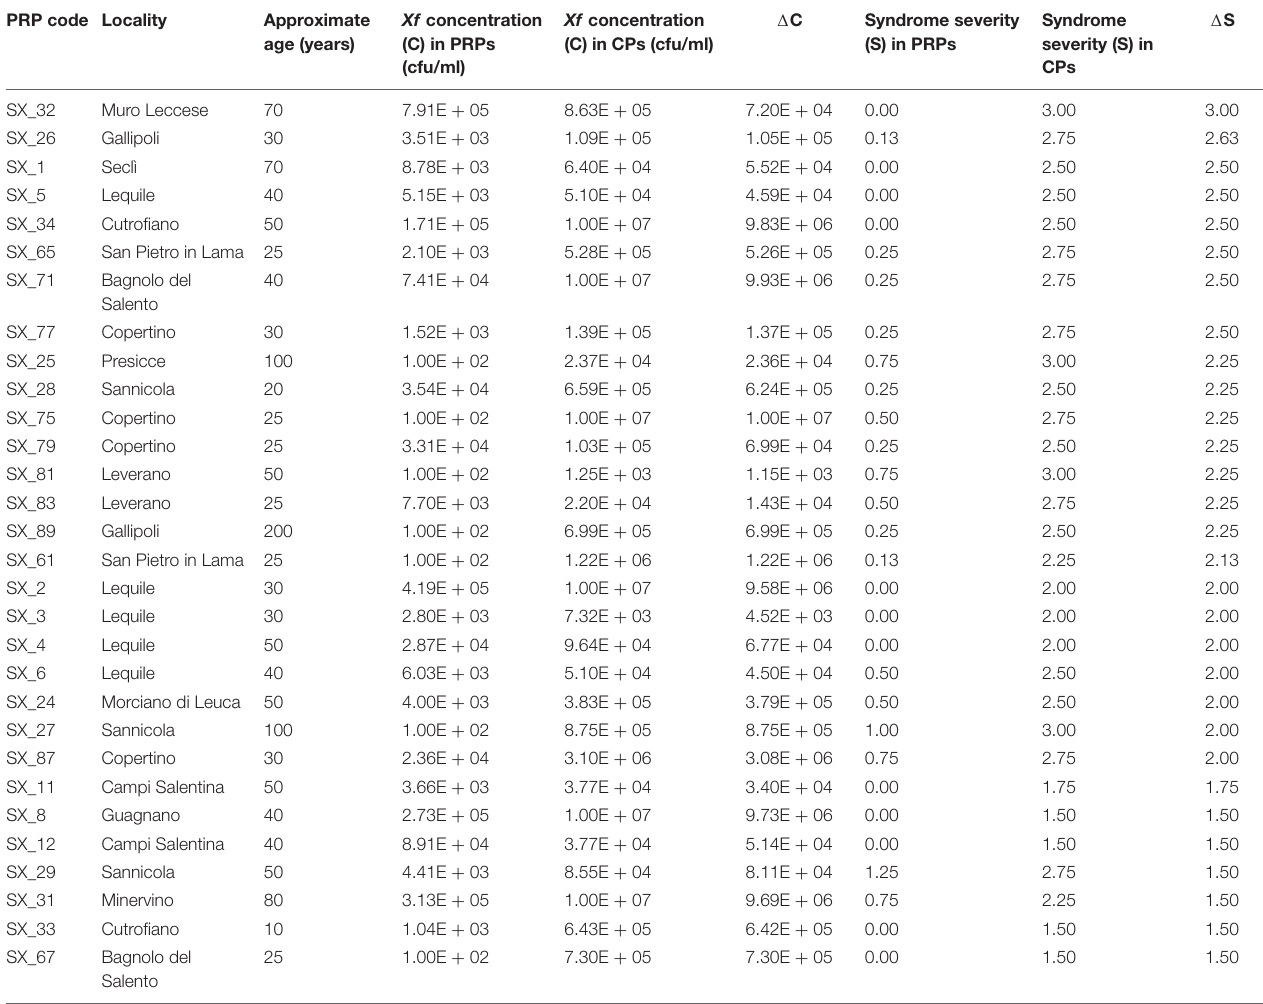
TABLE 1 | Features of putatively resistant plants (PRPs) identified in this study. PRP code